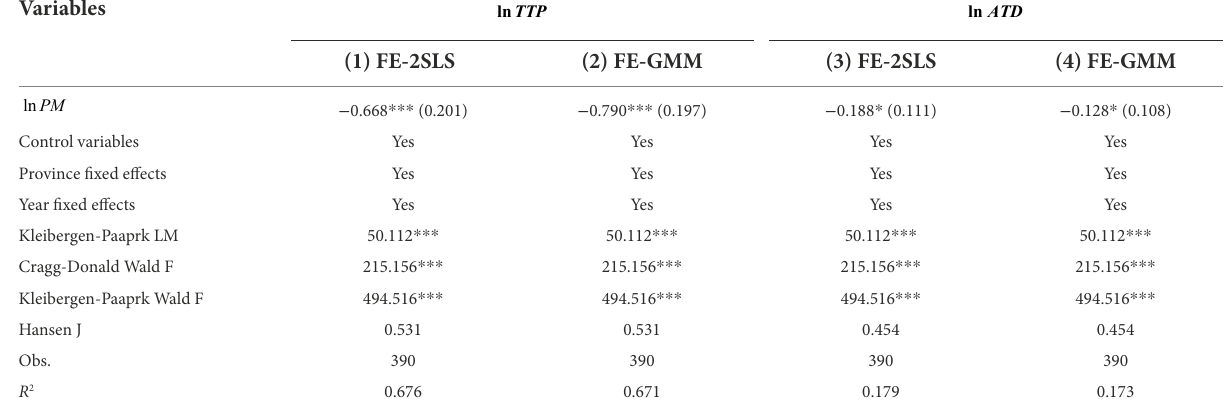
TABLE 4 Instrumental variables